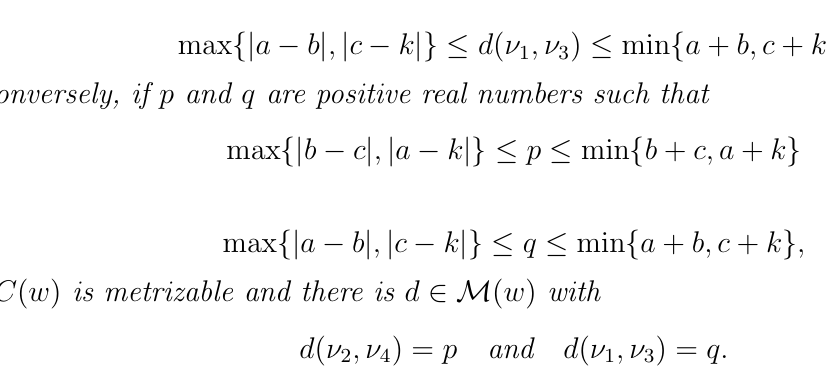
Figure 2: Here C ( w ) is a weighted cycle with w ( { ν c and w ( { ν